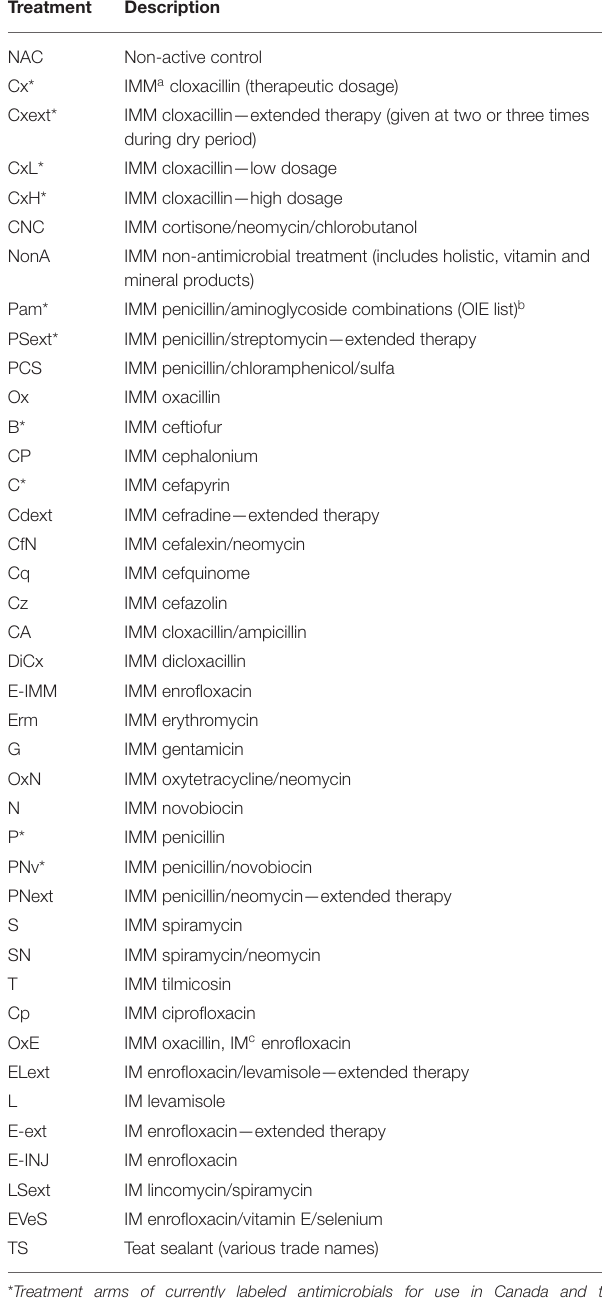
TABLE 2 | Description of the treatment arms included in the network meta-analysis assessing the relative efficacy of antimicrobial dry cow products for cure of existing IMI during the dry period, and the corresponding tables and